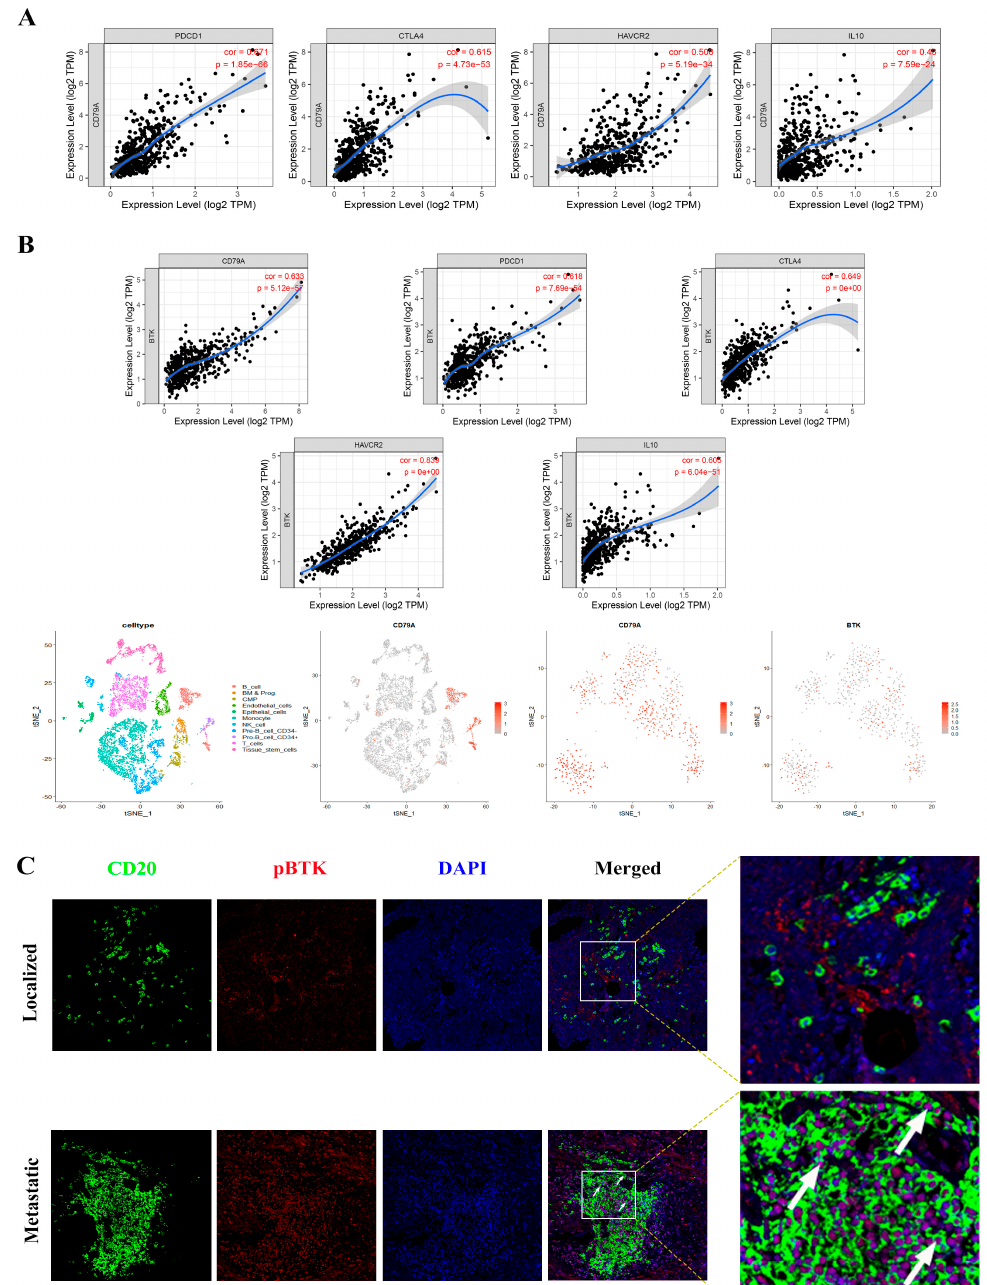
Figure 1. Bruton’s tyrosine kinase (BTK) is largely expressed in tumor − infiltrating B cells and associated with immunosuppressive molecules in human metastatic prostate cancer (PCa). ( A ) Cor- relation analysis of gene expression in PCa tissues from a public database (TIMER) reveals that CD79A (commonly known as a B cell marker) is positively associated with the expression of PDCD1, CTLA4, HAVCR2, and IL-10. ( B ) BTK expression is positively associated with the expression of CD79A, IL-10, and PDCD1. Additionally, single-cell RNA-seq analysis from a published dataset (GSE143791) containing metastatic PCa samples revealed that BTK is highly expressed in B cells (CD79A) infiltrated in metastatic PCa. ( C ) Representative mIHC images show that the phosphory- lation of BTK in tumor-infiltrating B cells is mainly observed in metastatic PCa. The white arrows indicate the BTK-phosphorylated B cells (original magnification: 400 × ). A p value less than 0.05 is statistically